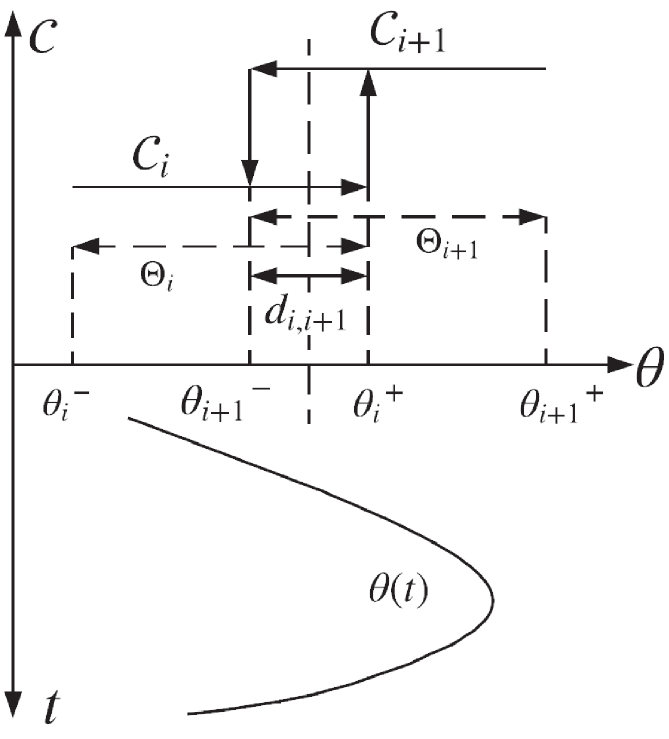
Fig 6. Hysteresis